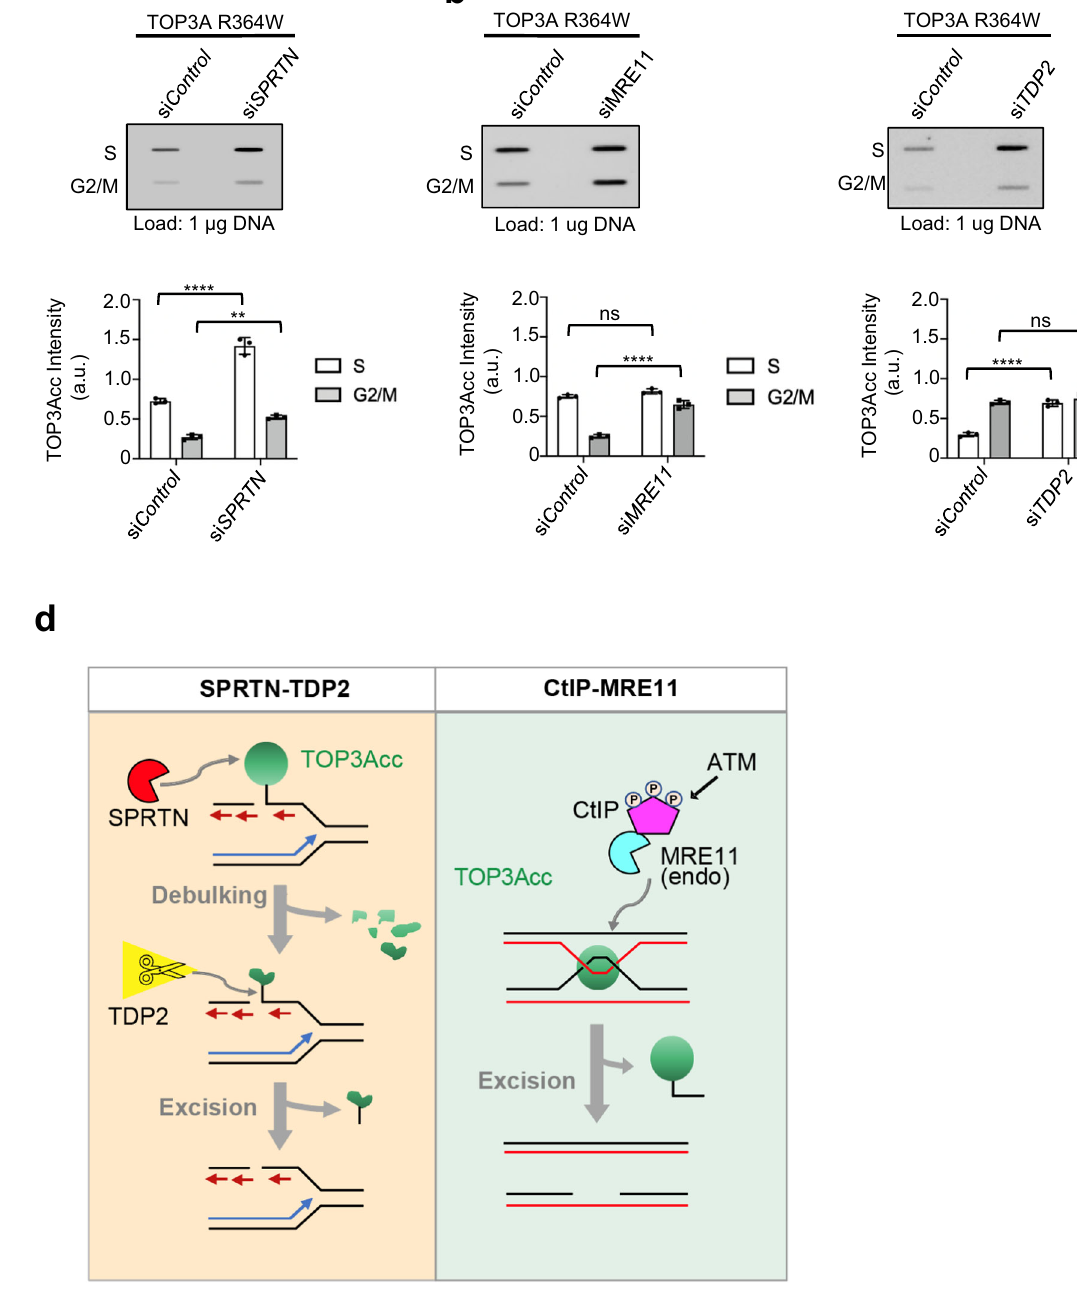
Fig. 7 | Proposed model for parallel pathways resolving stalled cellular TOP3Accs.a – c DifferentialrolesofSPRTN,MRE11andTDP2forTOP3Accsrepairas afunctionofcellcycle.U2OScellsweretransfectedwitheithersi Control orsi SPRTN ( a ),si MRE11 ( b ),si TDP2 ( c )followedbyco-transfectionwithTOP3A-R364W.Cells(in S and G2/M phase) were collected after synchronization by double-thymidine block. RADAR assays were performed with anti-TOP3A antibody. Representative slot-blot images are shown. Quantitation from three independent RADAR assays is shown to the bottom of slot blot images. Error bar indicates mean±SE. Statistical signi fi cancewasdeterminedbytwo-wayANOVAwithSidak ’ smultiplecomparisons test. ****Adjusted p -value ≤ 0.0001(si Control vs si SPRTN : S-phase, si Control vs si TDP2 : S-phase, si Control vs si MRE11 : G2/M-phase), **Adjusted p -value=0.0016